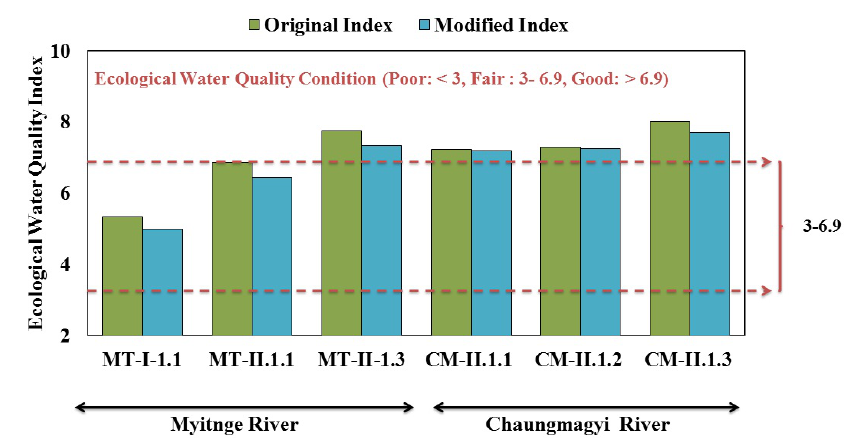
Figure 5. Ecological water quality indices of six samples based on the original Asia Foundation Method and Myanmar Modified Method. Dotted line shows Fair condition according to the